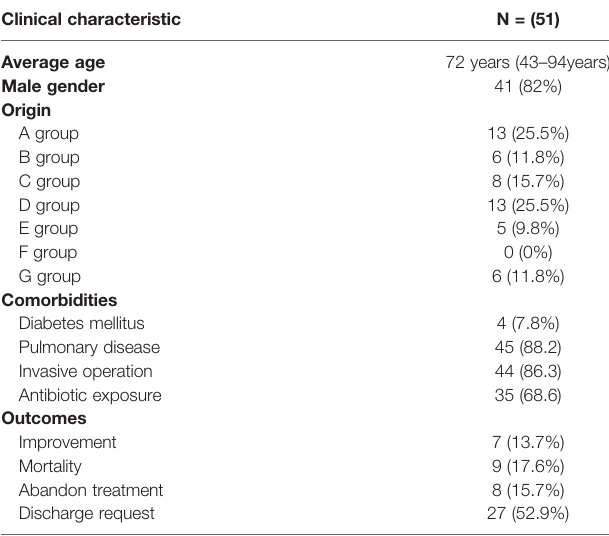
TABLE 1 | Clinical characteristics of ICU